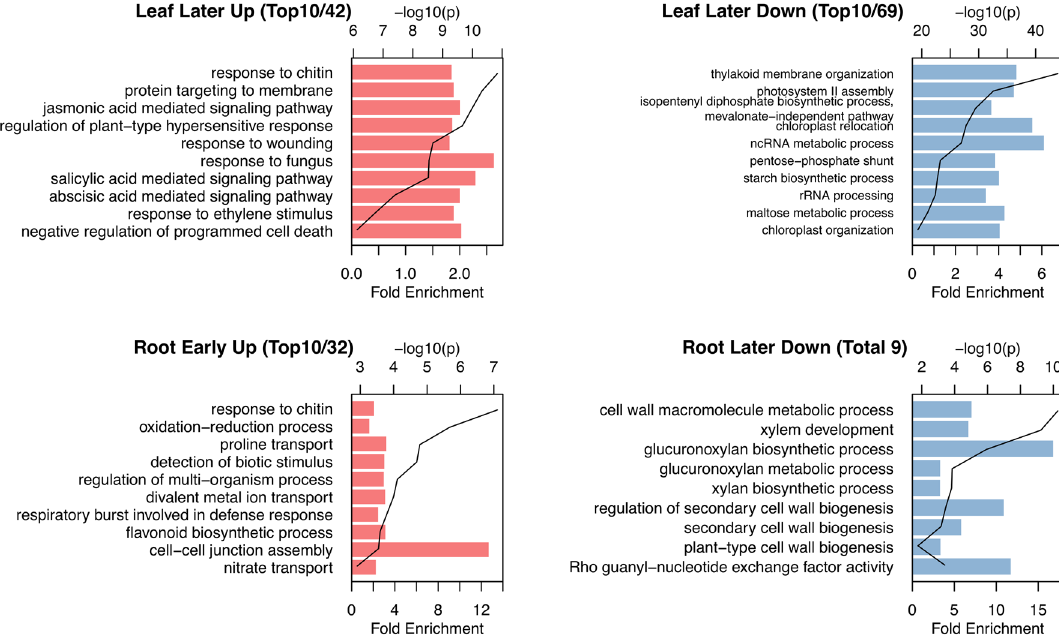
Figure 3. Gene ontology enrichment analysis of differential expression genes at early or later growth stage in the leaf and root. Gene expression profiles were classified into six patterns; significant increase or decrease (FDR < 0.05; fold change ≥ 2) only between 4 and 6 WAP (early stage), 6 and 8 WAP (mid stage), or 8 and 11 WAP (later stage) and no significant difference at the other stage. GO enrichment analysis was carried out using the Soybase GO term enrichment tool (https:// www. soyba se. org). GO, gene ontology; FDR, false discovery rate; WAP, weeks after planting.